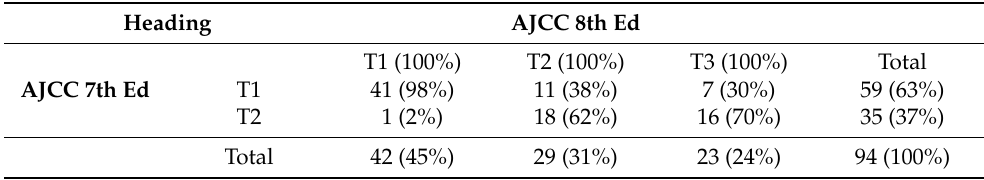
Table 2. Stage migration from AJCC 7th to AJCC